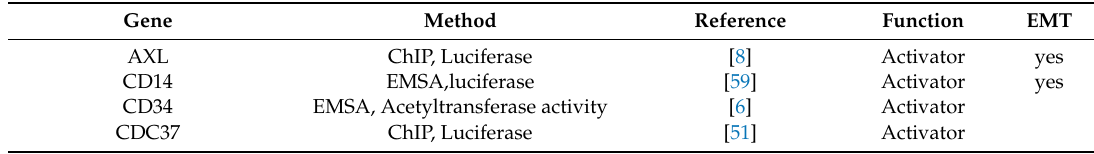
Table 1. MZF1 target genes; their method of identification (ChIP: chromatin immunoprecipitation; EMSA: electrophoretic mobility shift assay), reference, function (the role of MZF1) and their involvement generally in EMT (yes, if involvement has been